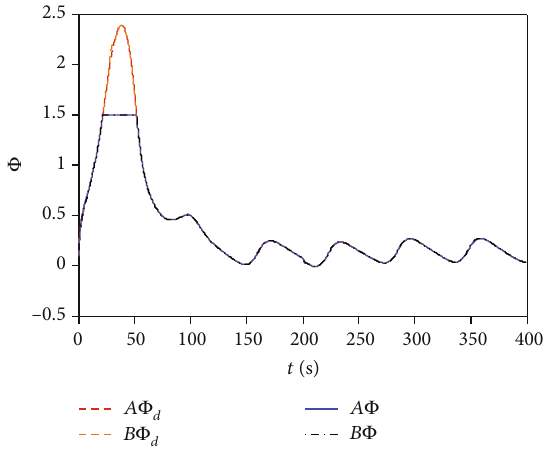
Figure 9: Curves of fuel equivalent ratio.